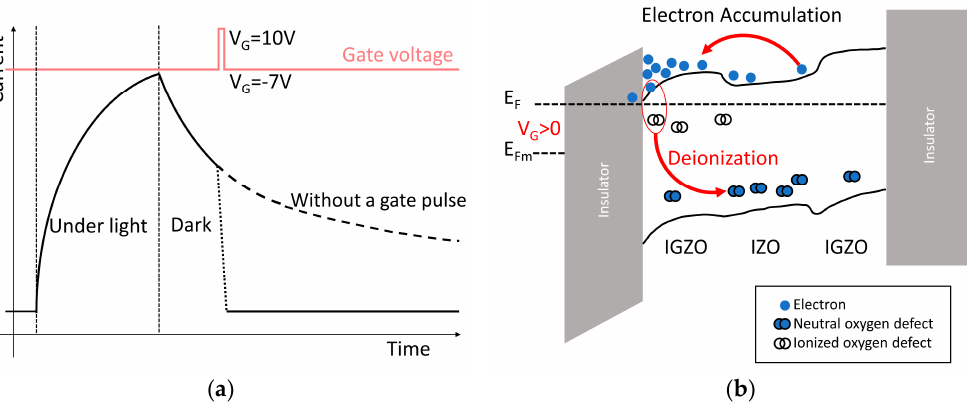
Figure 5. ( a ) Conceptual plot of the drain current of the TCO-based optical device. Here, the positive gate pulse makes dark signal level after illumination as same as the level before illumination as illustrated in this figure. ( b ) Energy band diagram of the device when positive gate pulse is applied. Here, it is described that the increased electron concentration of the film accelerates deionization of the oxygen defect (redrawn and adopted from